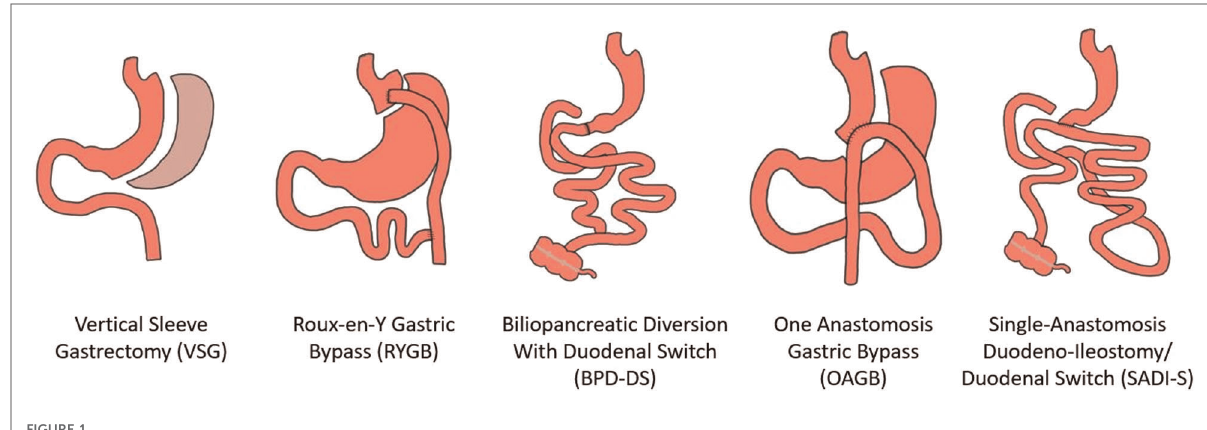
FIGURE 1 Metabolic/bariatric